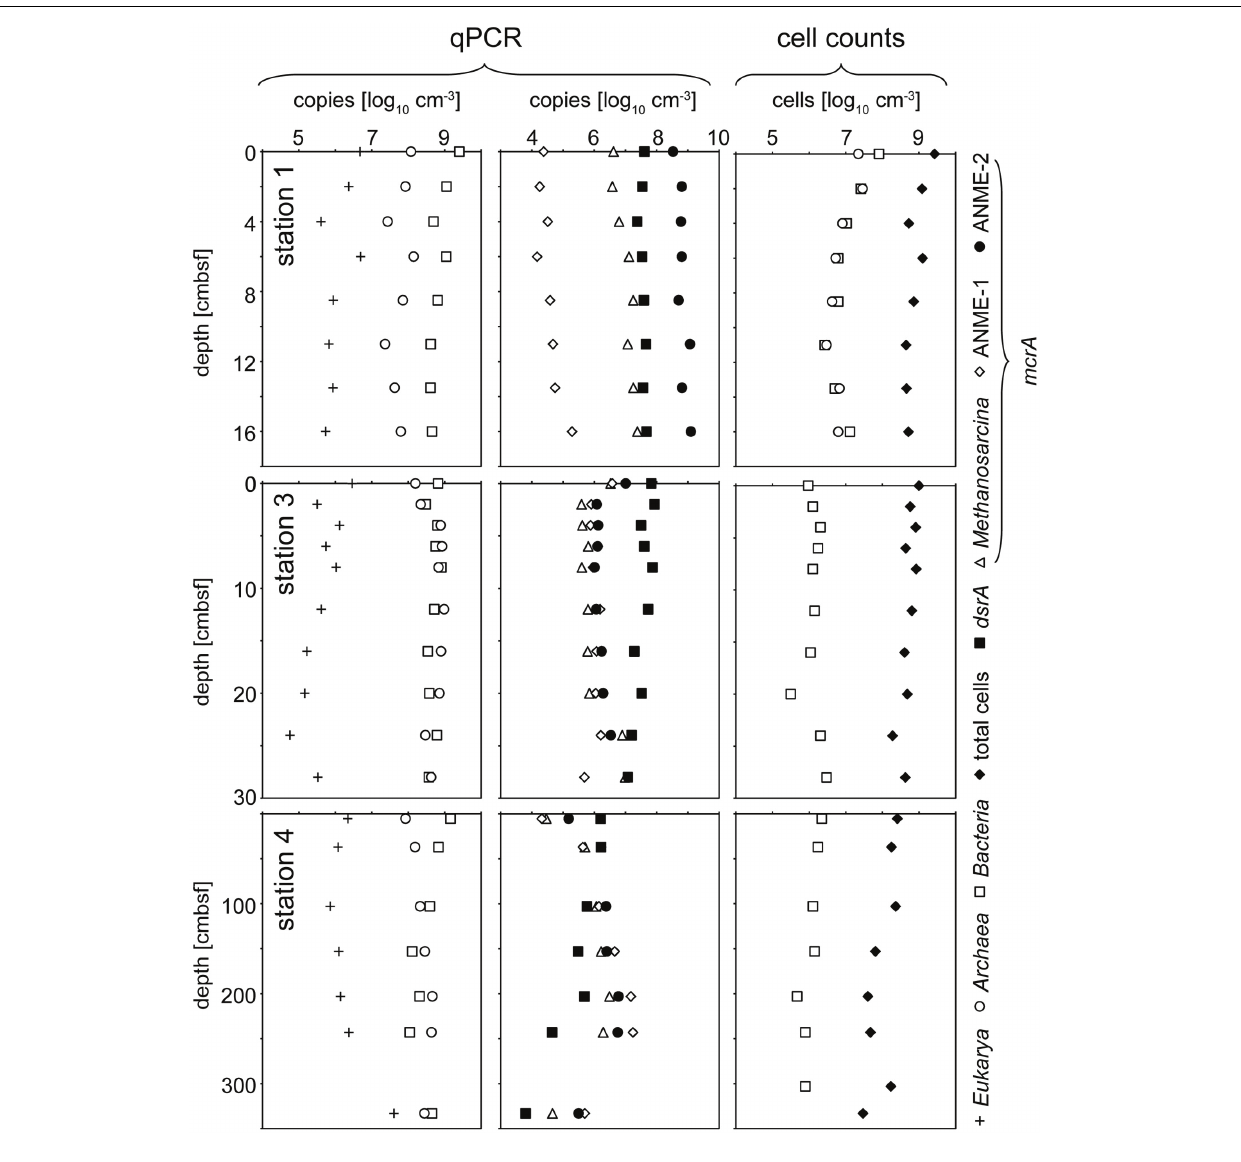
FIGURE 4 | Depth trend of quantitative community composition of three different stations from the Simeulue seep. The left panel illustrates the composition of the three domains Bacteria, Archaea and Eukarya according to qPCR quantification of 16S or 18S rRNA genes,